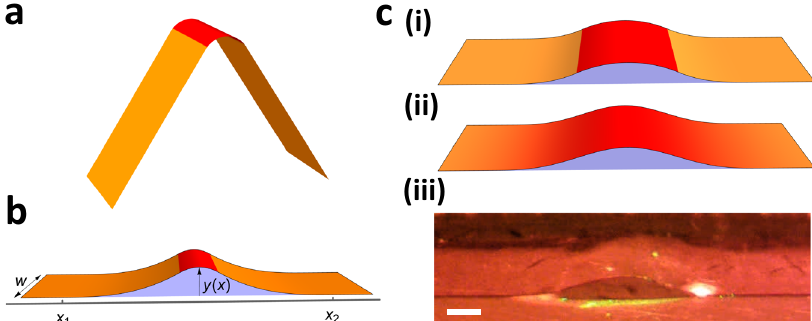
Fig.2|Modellingtheshapeoftheactuatedperistalticpump.a BluntedV-shape deformation minimising the elastic energy in the absence of liquid. b Schematic picture of the pump, showing the quantities used in the development of the the- oretical model. c Comparison of deformation pro fi les of 3.7mm wide strips pre- dicted bytheoryusing(i)rectangularand(ii)Gaussianpreferredcurvaturepro fi les